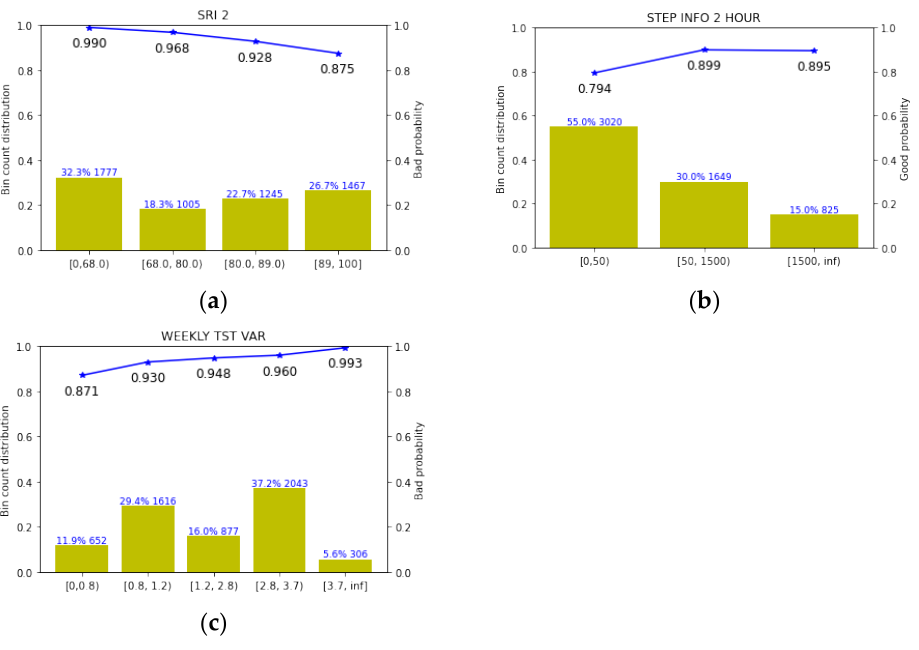
Figure 9. ( a ) Sleep state probabilities for SRI interval; ( b ) sleep state probabilities for STEP_INFO_2 interval; ( c ) sleep state probabilities for WEEKLY_TST_VAR interval.